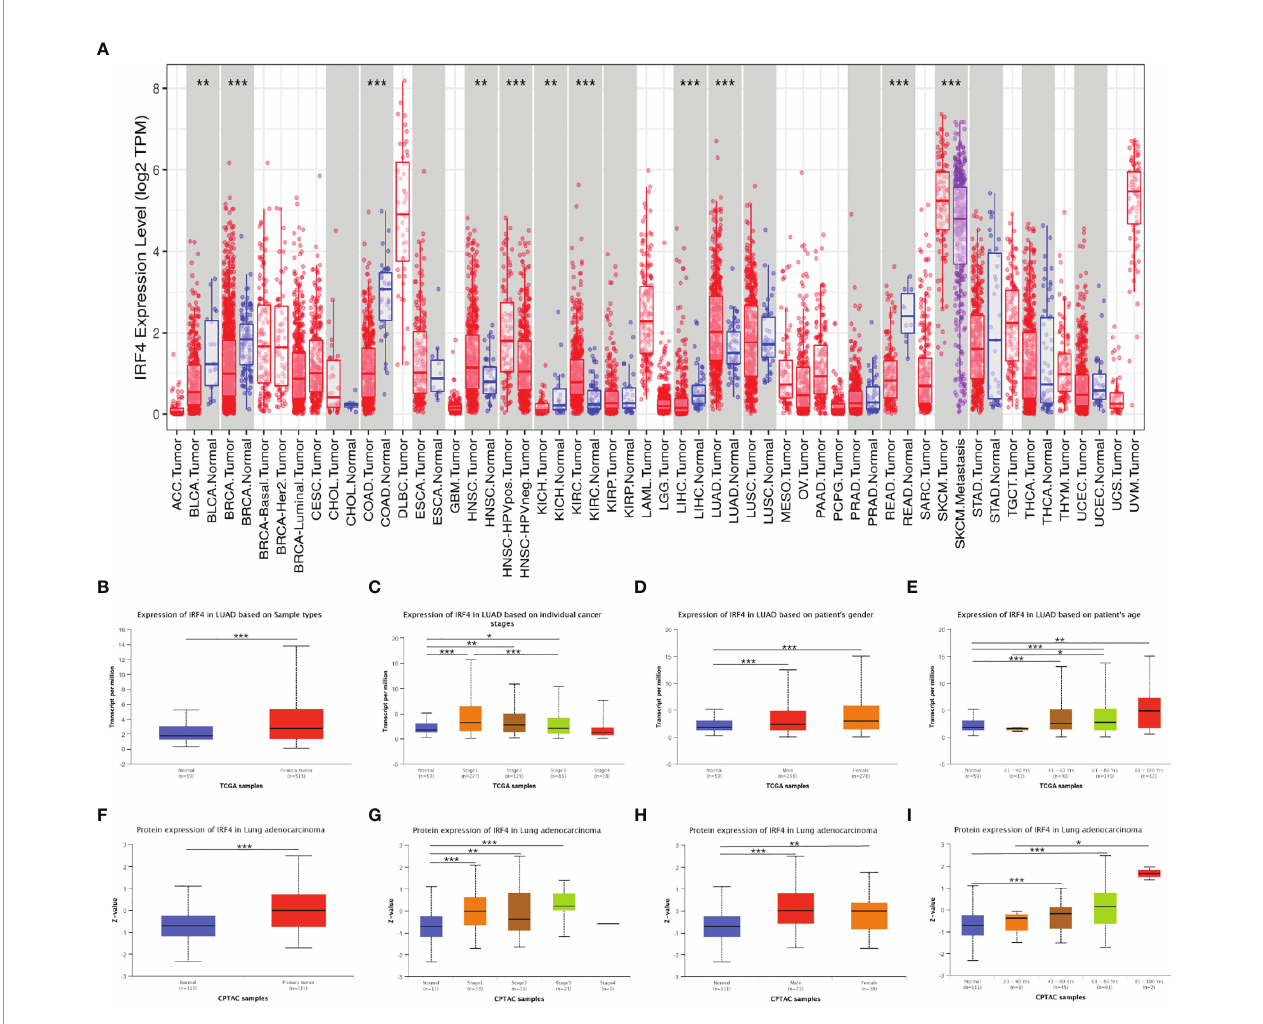
FIGURE 1 | IRF4 expression levels in LUAD and other cancer types. (A) IRF4 expression levels in different tumor types from TCGA database were detected by TIMER. (B – I) Box plots showing IRF4 mRNA and protein expression levels in LUAD based on sample type, stage, gender and age by UALCAN database. (0 ≤ *** P < 0.001 ≤ ** P < 0.01 ≤ * P < 0.05). LUAD, Lung